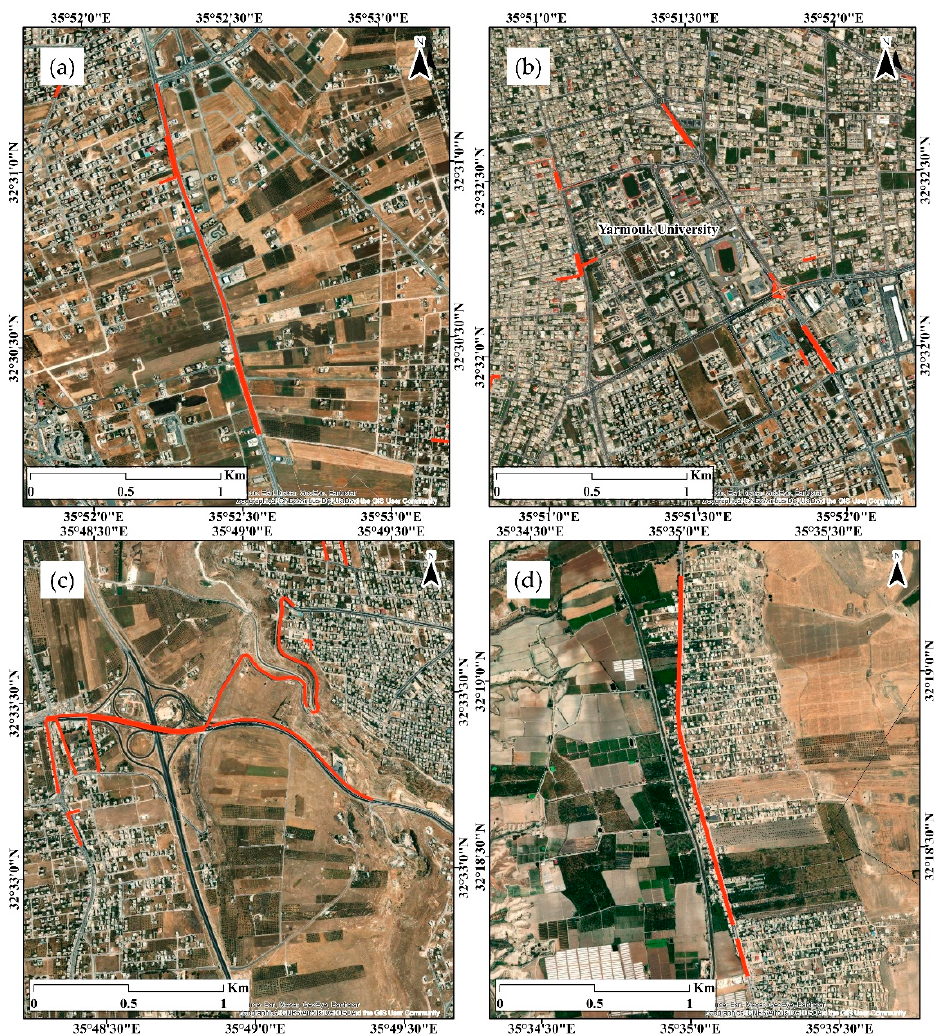
Figure 10. Examples the fatal and severe injury hotspot locations that have the highest confidence level. ( a ) a section of the arterial road that links Irbid city with the capital, Amman ( b ) the major sections in Irbid city, ( c ) the arterial road that links Irbid city with the towns in the Jordan Valley, ( d ) a section of the Jordan Valley Road. Refer to Figure 9 for reference location.